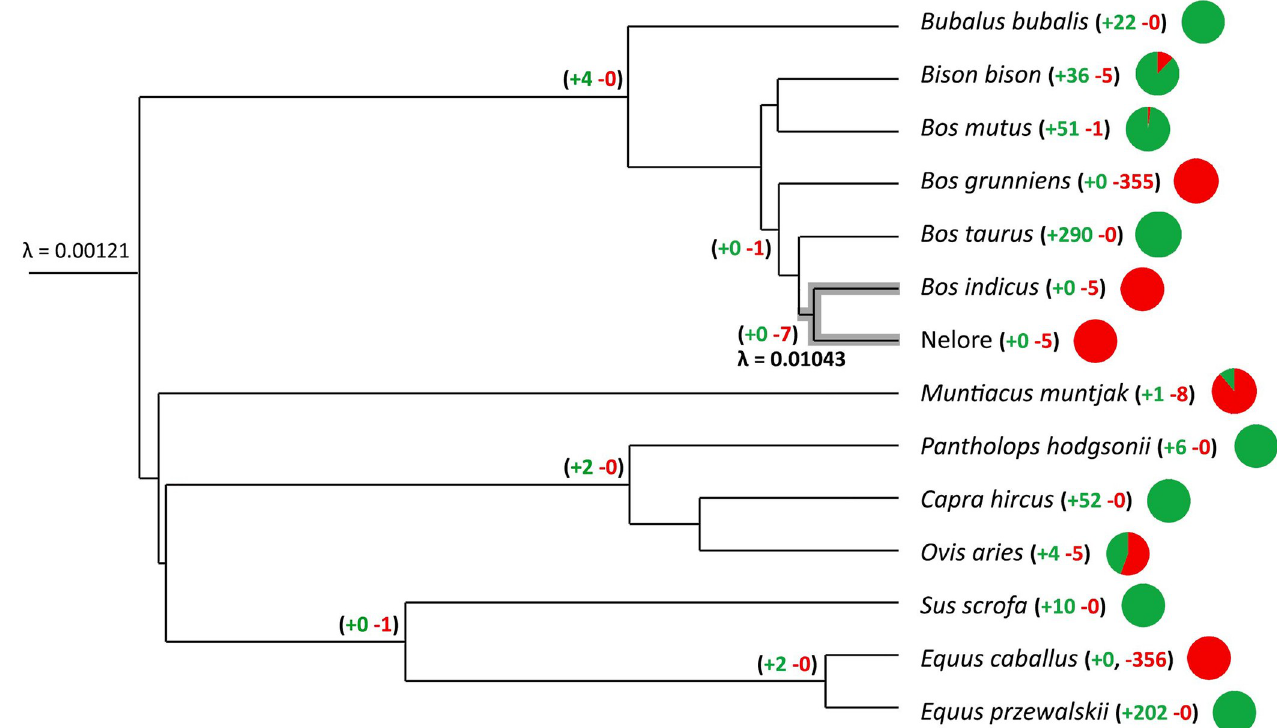
Fig 5. Gene family’s expansion or contraction across all branches and terminal taxa. Branch numbers indicate the number of expanding (green) and contracting gene families (red). Pie charts represent the proportion of expansions and contractions per species.